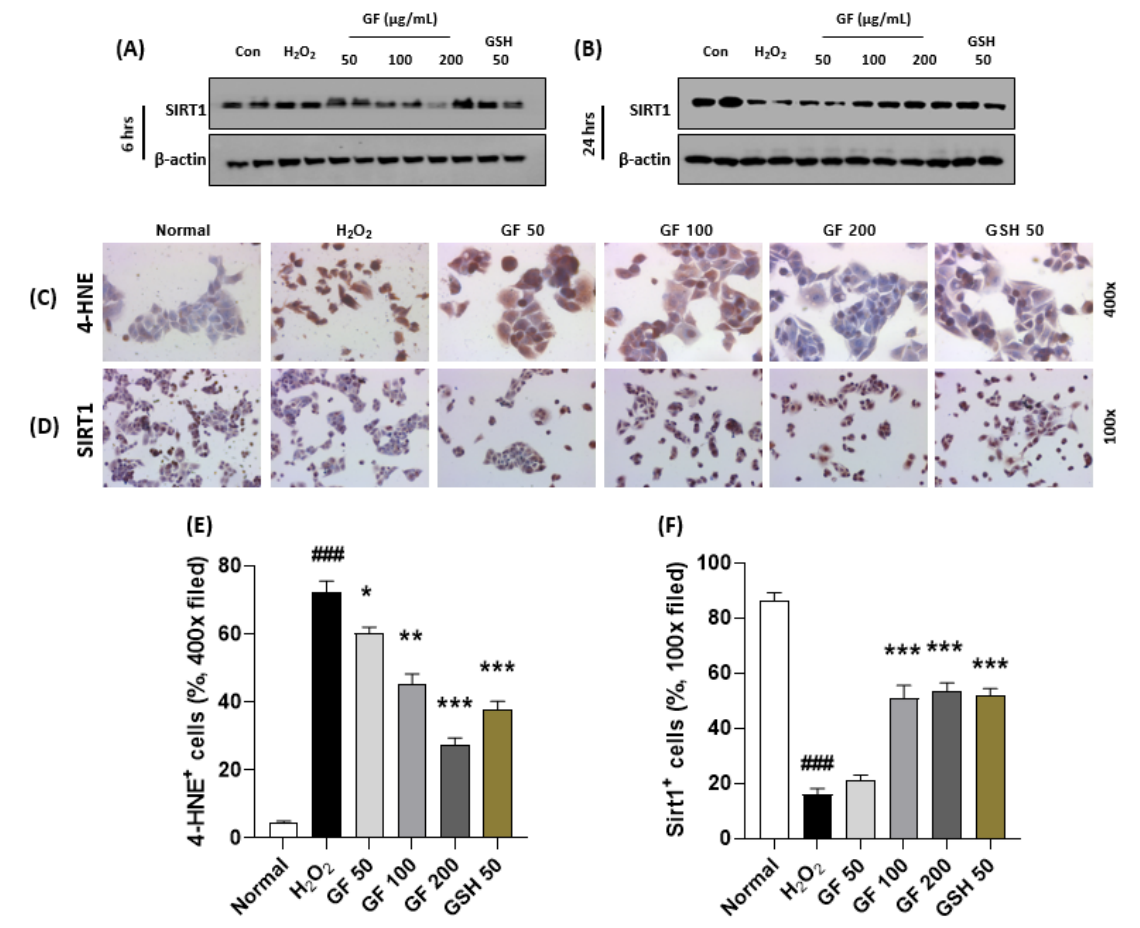
Figure 6. GF attenuates hepatocyte oxidative stress via prevention from SIRT1 depletions. Western blot analysis in H 2 O 2 (500 μ M) treated HepG2 cells for 6 h or 24 h with or without GF (50, 100, 200 μ g/mL). Cellular protein levels of SIRT1 for 6 h ( A ) and 24 h ( B ). IHC analysis against 4-HNE ( C ) and SIRT1 ( D ). Quantification analysis of 4-HNE ( E ) and SIRT1 ( F ). Data were expressed mean ± SEM ( n = 4 for IHC analysis). ### p < 0.001 for Normal vs. H 2 O 2 and * p < 0.05, ** p < 0.01, and *** p < 0.001 for H 2 O 2 vs. GF or GSH. IHC images were captured by microscope condition (100- or 400-× magnifications).